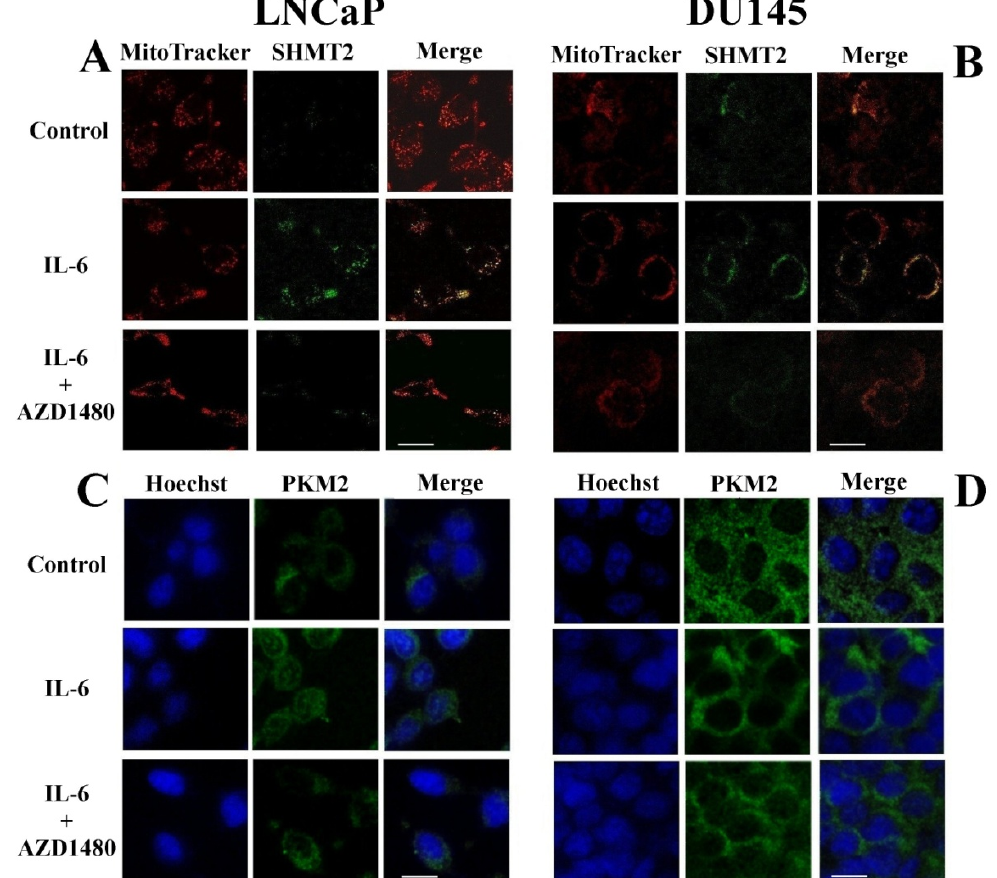
Figure 7. Cellular redistribution of SHMT2 and PKM2 following IL-6 stimulation. Immunofluorescence analysis of SHMT2 ( A , B ) and PKM2 ( C , D ) proteins in LNCaP and DU145 cells after 4 h of IL-6 stimulation, with or without a Jak2 inhibitor (AZD1480). ( A , C ) LNCaP cell line. ( B , D ) DU145 cell line. The images were captured with a confocal fluorescence microscope (ZEISS LSM510META) using 60x oil immersion objective (scale bar 10 µm).